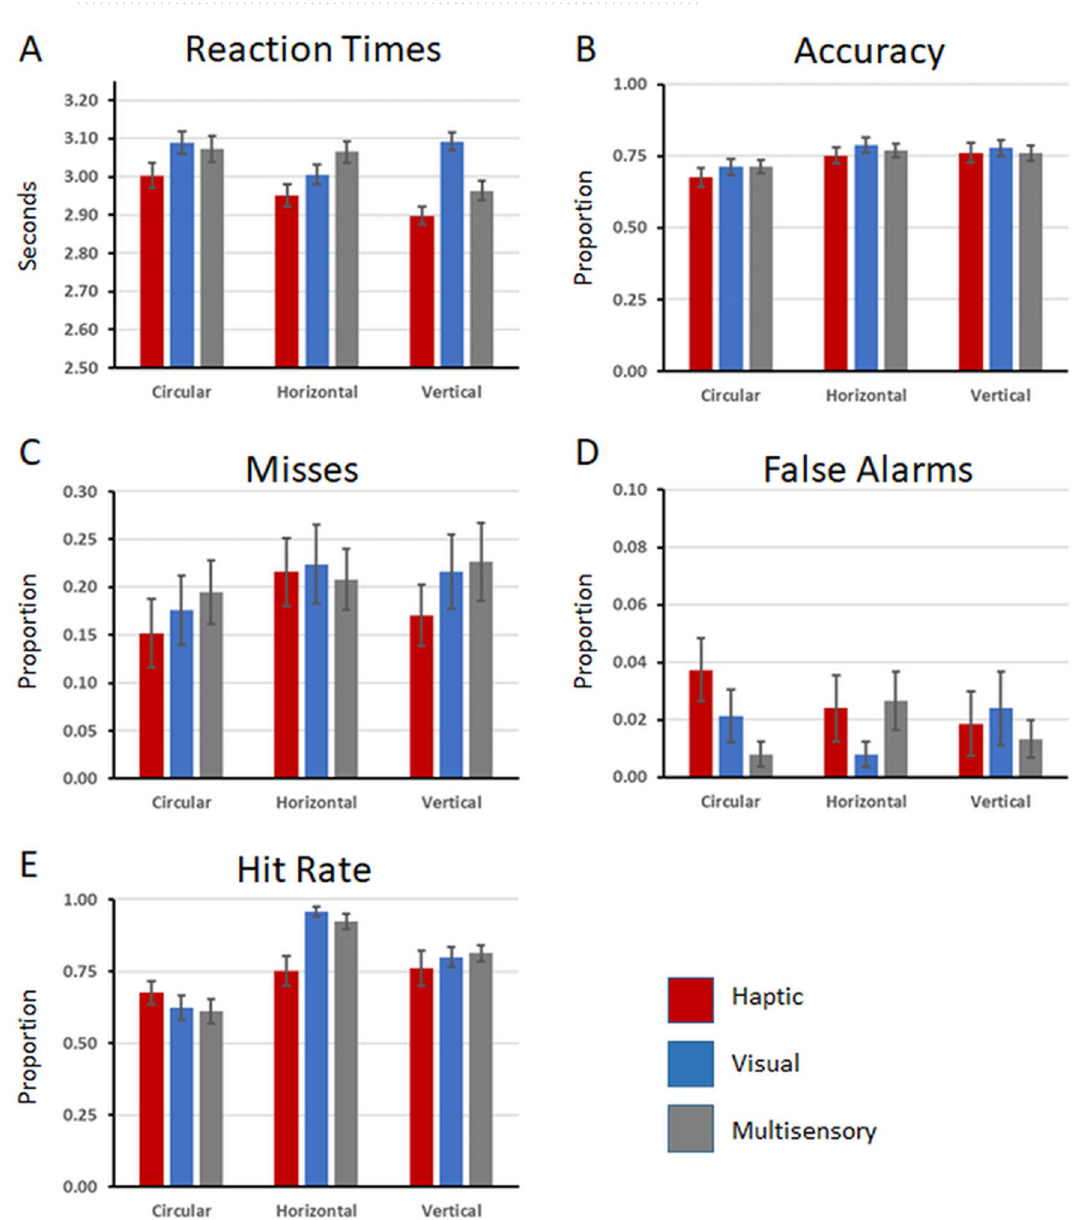
Figure 2. Group-averaged (N = 25) behavioural results from the VST ( A–D ) and from the tablet task ( E ). ( A ) Reaction times on the VST measured in seconds. ( B ) Accuracy on the VST measured as a proportion. ( C ) Misses on the VST measured as a proportion. ( D ) False Alarms on the VST measured as a proportion. ( E ) Hit rates on the tablet task measured as a proportion. Across all of the panels, the error bars indicate the standard error of the